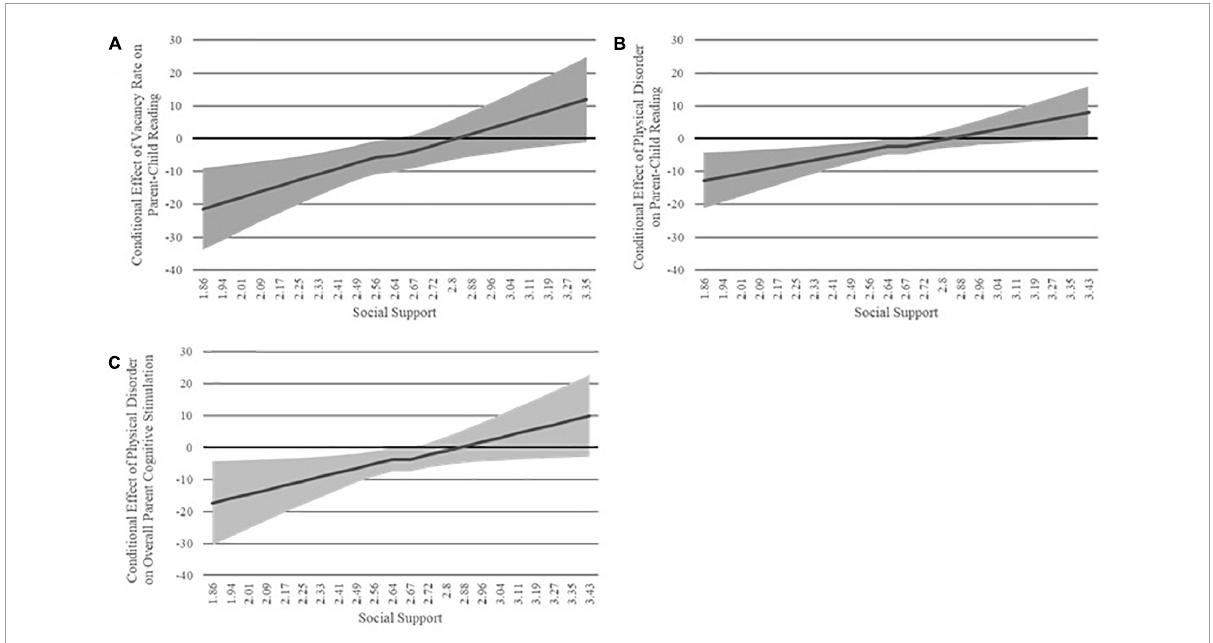
FIGURE3 Johnson-Neyman plots indicating regions of significance for the conditional effect of (A) vacancy rate on parent-child reading, (B) observed physical disorder on parent-child reading, and (C) observed physical disorder on overall parent cognitive stimulation across levels of social